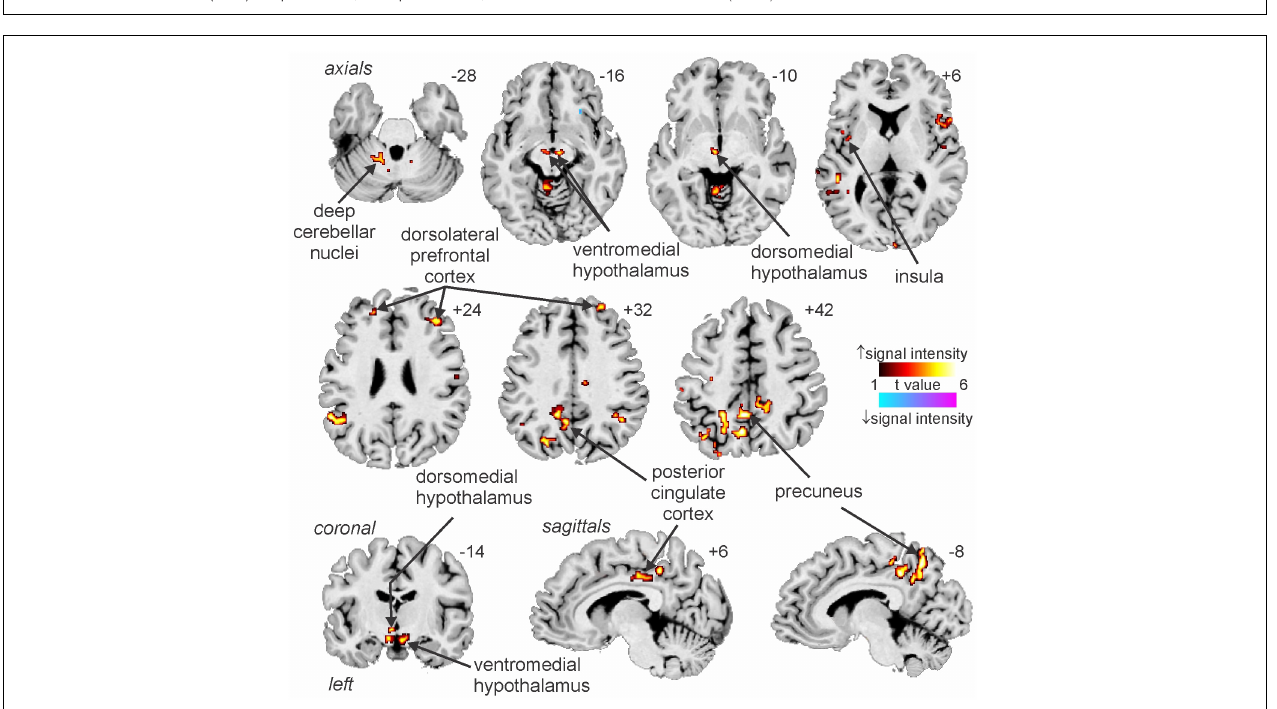
FIGURE 3 | Increases and decreases in functional magnetic resonance imaging (fMRI) signal intensity correlated with muscle sympathetic nerve activity (MSNA) in 14 healthy participants. The hot color scale indicates regions in which signal intensity was high during periods of high MSNA and low during low MSNA. Conversely, the cool color scale indicates regions where signal intensity was high during low MSNA and low during high MSNA. Clusters are overlaid onto axial, coronal and sagittal slices of an individual subject’s T1-weighted anatomical and slice locations in Montreal Neurological Space are shown at the top right of each section. Reproduced, with permission, from James et al.